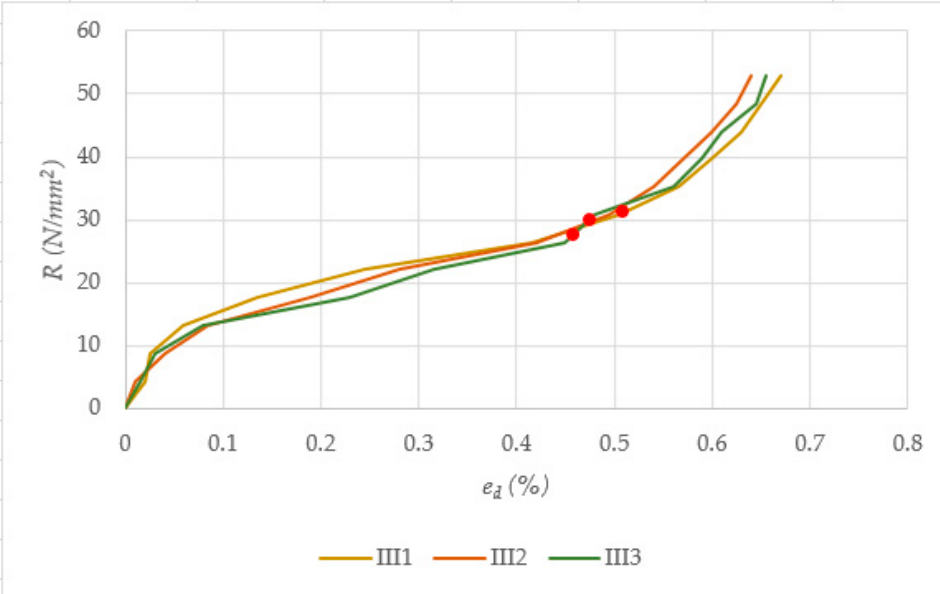
Figure 10. Stress–strain curves for samples without reinforcements.